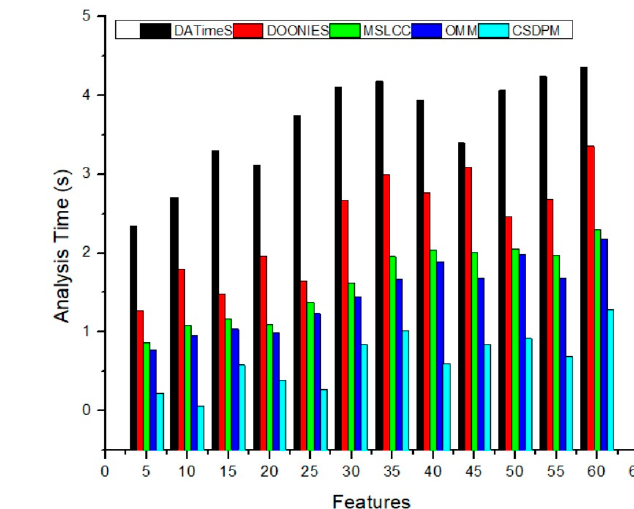
Figure 12. Analysis time.